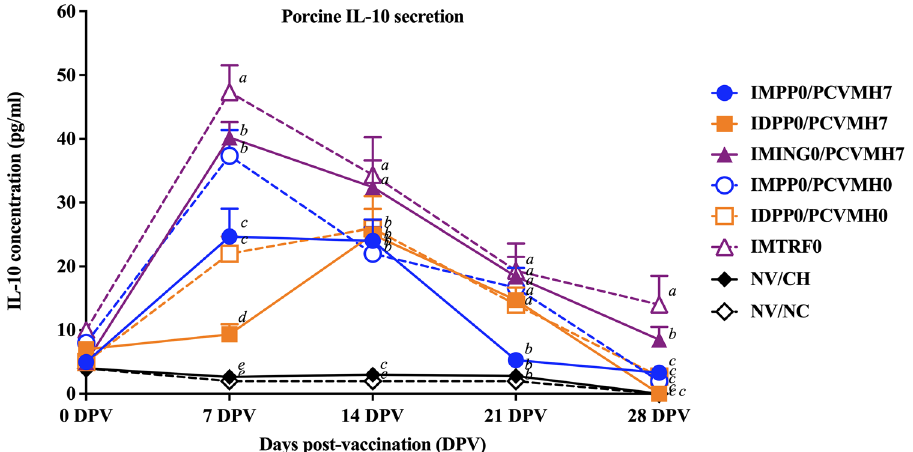
Figure 3. Quantification of porcine IL-10 secretion in stimulated PBMC with homologous viruses (vaccine viruses). Values expressed as mean ± SEM. The results were compared using two-way ANOVA for multiple comparisons. Different lowercase letters (a–d) indicate significant differences between treatment groups ( p < 0.05) for each